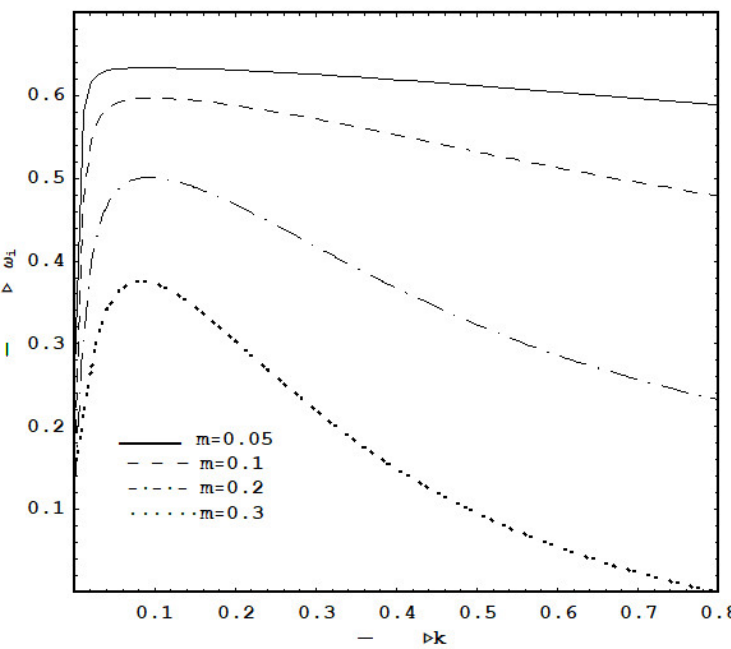
Figure 17. Variation the growth rate ω i with the wavenumber k for different values of the the porosity of the medium, m